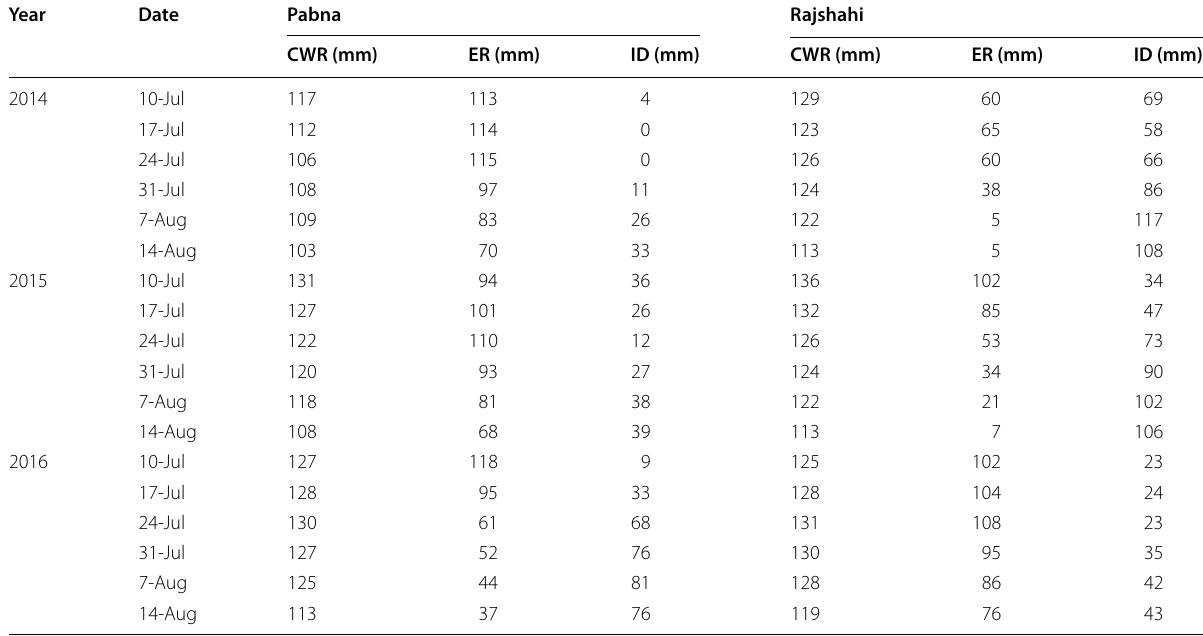
Table 4 Crop water requirement (CWR), effective rainfall (ER) and irrigation demand (ID) at reproductive phase in Pabna and Rajshahi under varying transplanting dates during T. Aman, 2014–2016